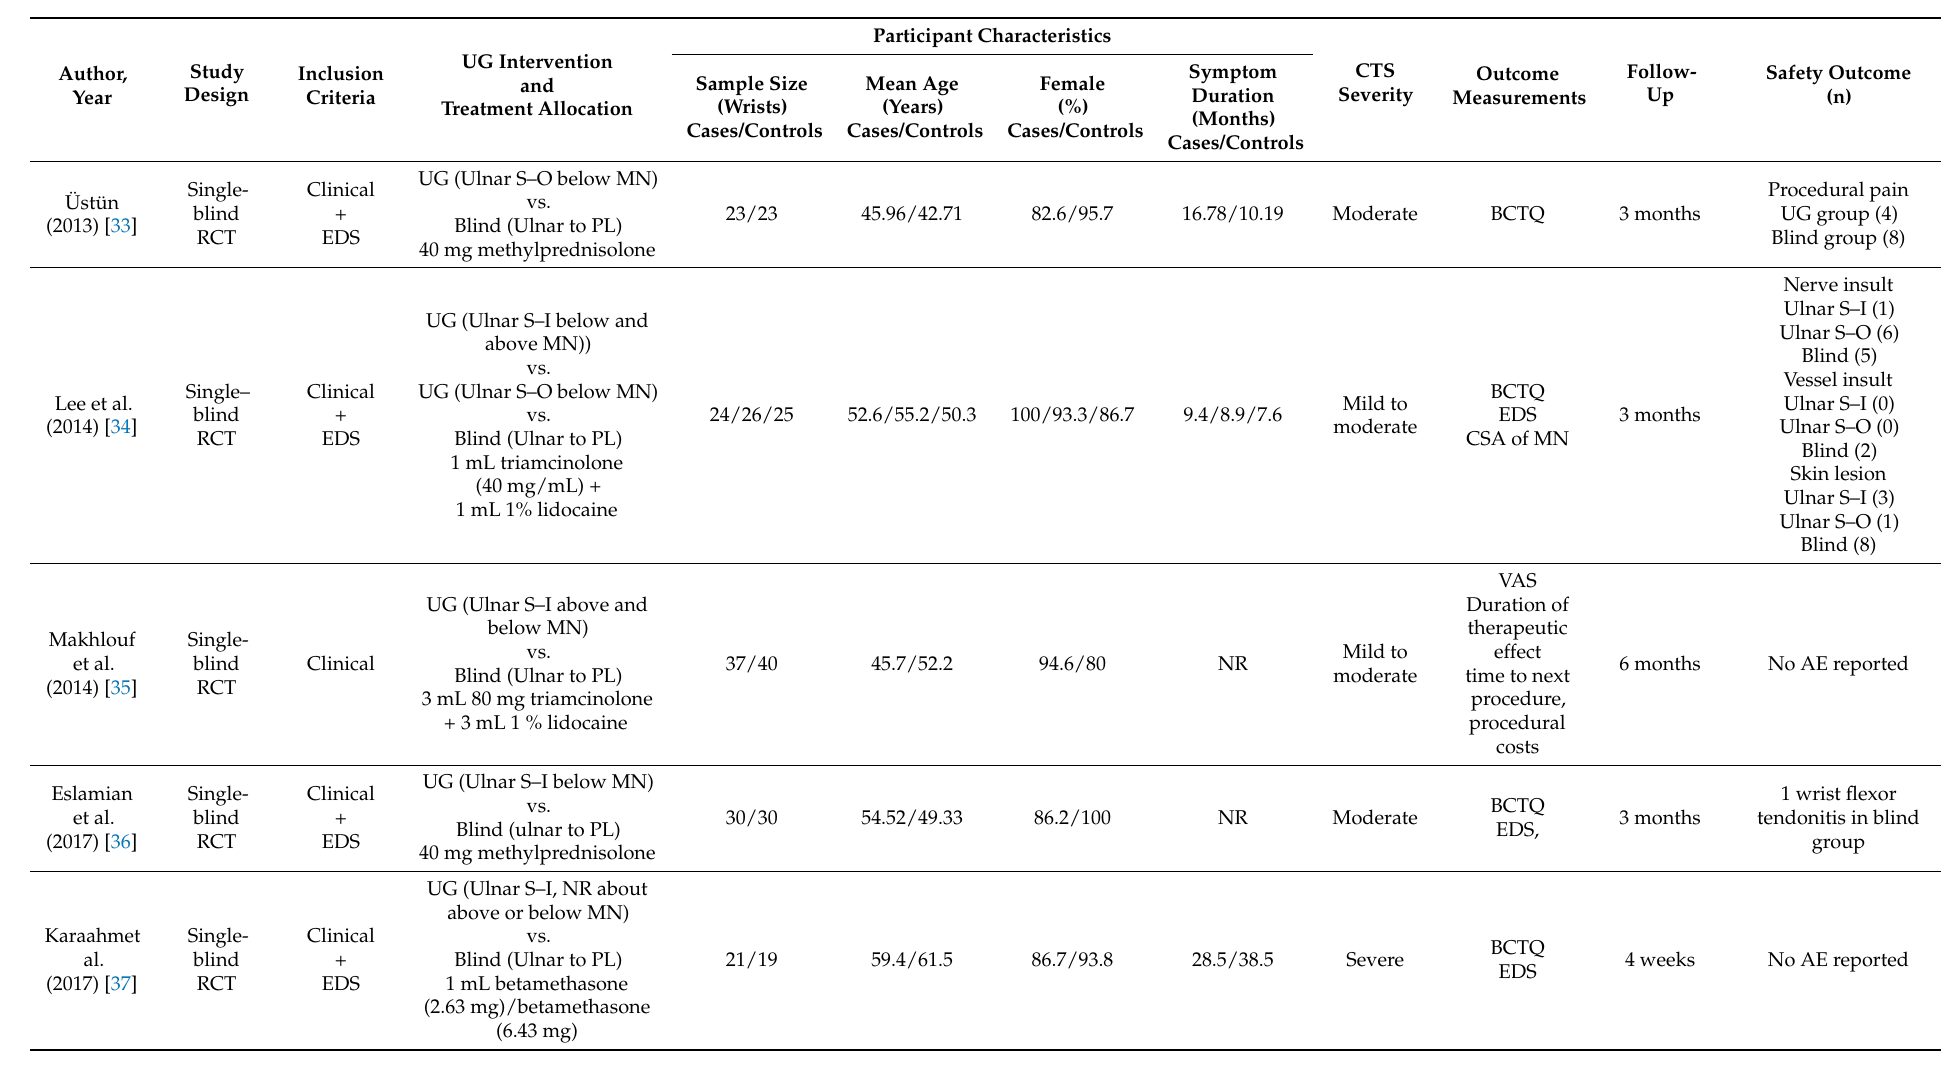
Table 4. Intervention details of included studies using ultrasound-guided corticosteroid injections for treating carpal tunnel